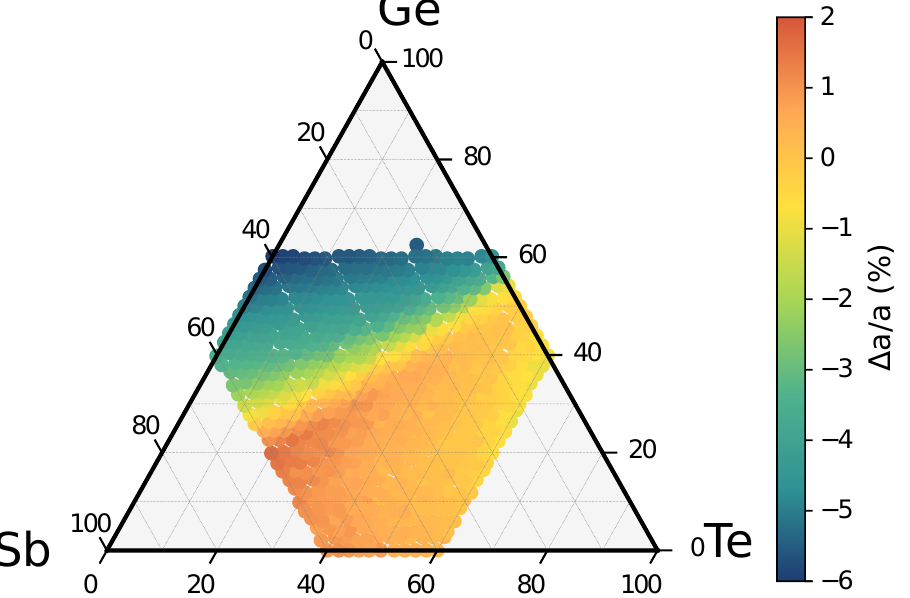
Figure 4. Map of the lattice parameter of the cubic phase of GST alloys in the ternary phase diagram. The lattice parameter is shown as the relative difference ( a − a 225 ) / a 225 in percentage (%) with respect to the lattice parameter of GST225 ( a 225 = 6.0293 Å)